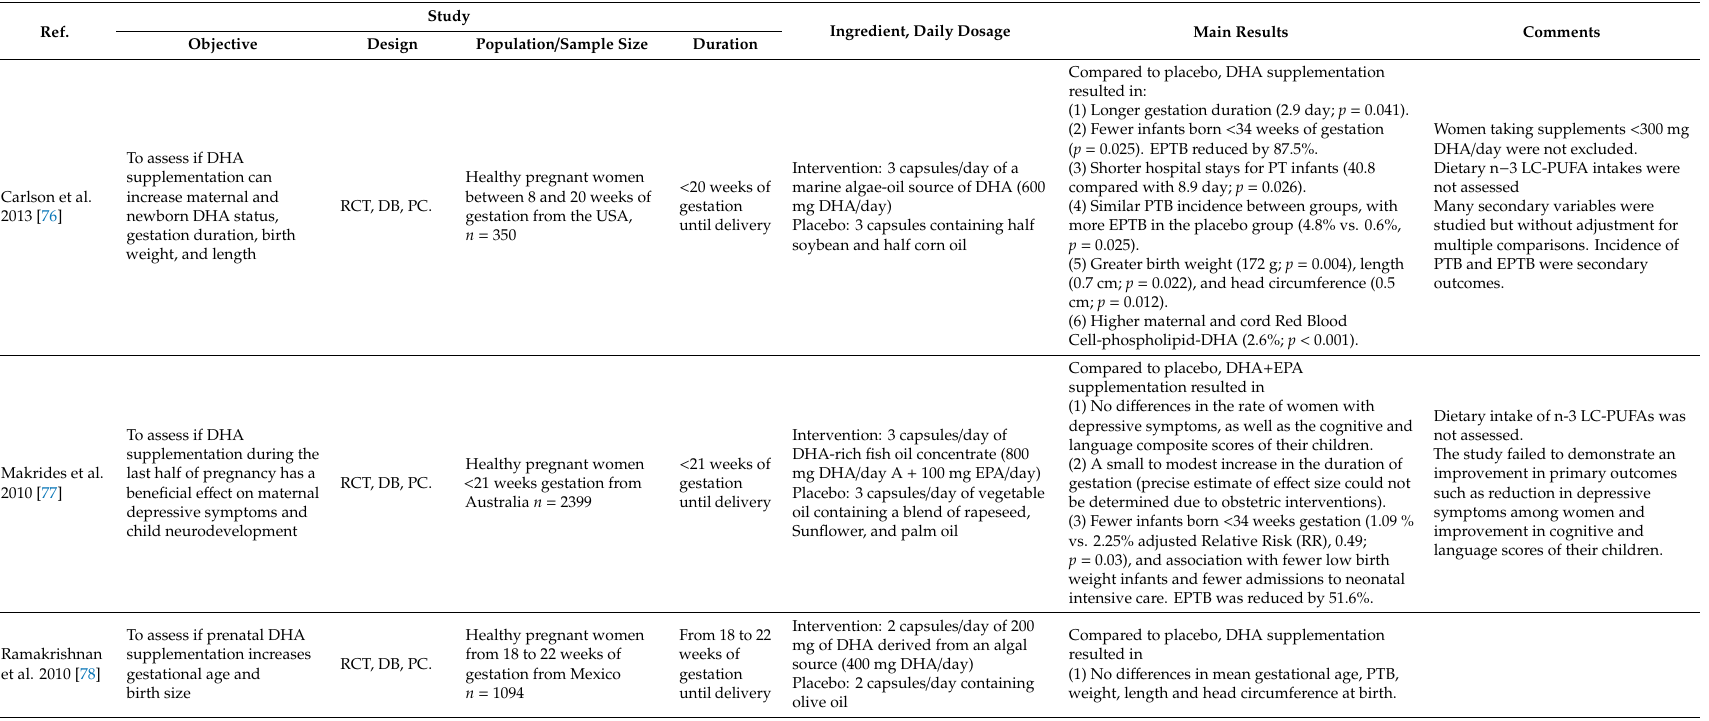
Table 1. Characteristics and e ffi cacy of clinical trials investigating the role of omega-3 fatty acids in reducing risk of early and any PTB.